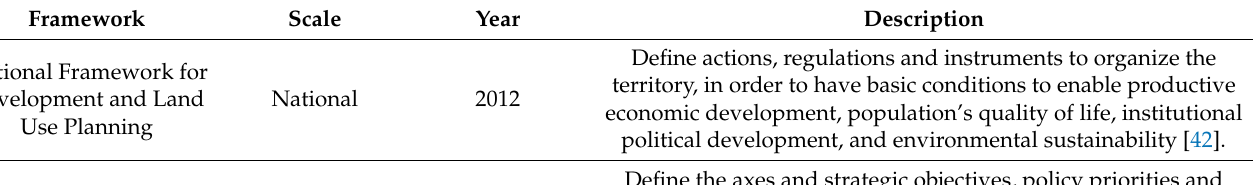
Table 1. Land-use planning framework in